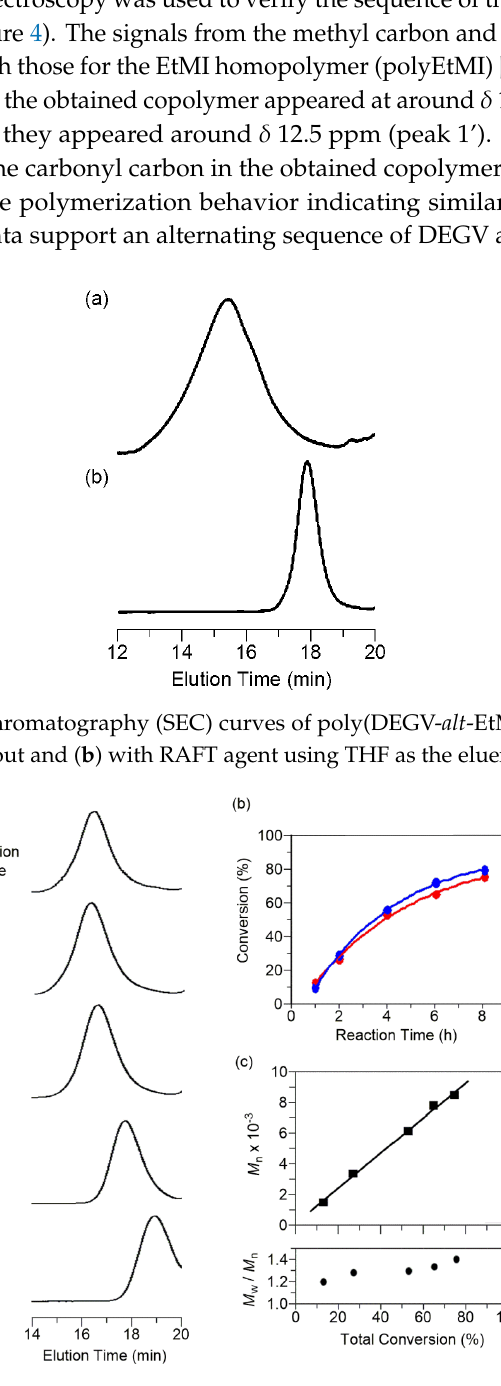
Figure 2. ( a ) SEC curves for poly(DEGV- alt -EtMI) measured in THF, ( b ) time-monomer conversion curves for the RAFT copolymerization of DEGV and EtMI with CPDB, and ( c ) M n and M w / M n values of poly(DEGV- alt -EtMI) plotted against total monomer conversion.